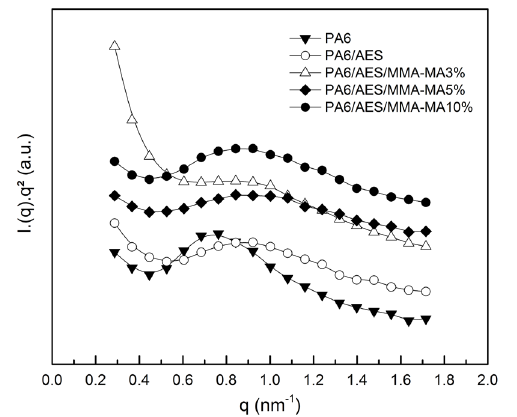
Figure 4. Lorentz corrected SAXS profiles for PA6; PA6/AES and blends compatibilized with MMA-MA synthetized with different